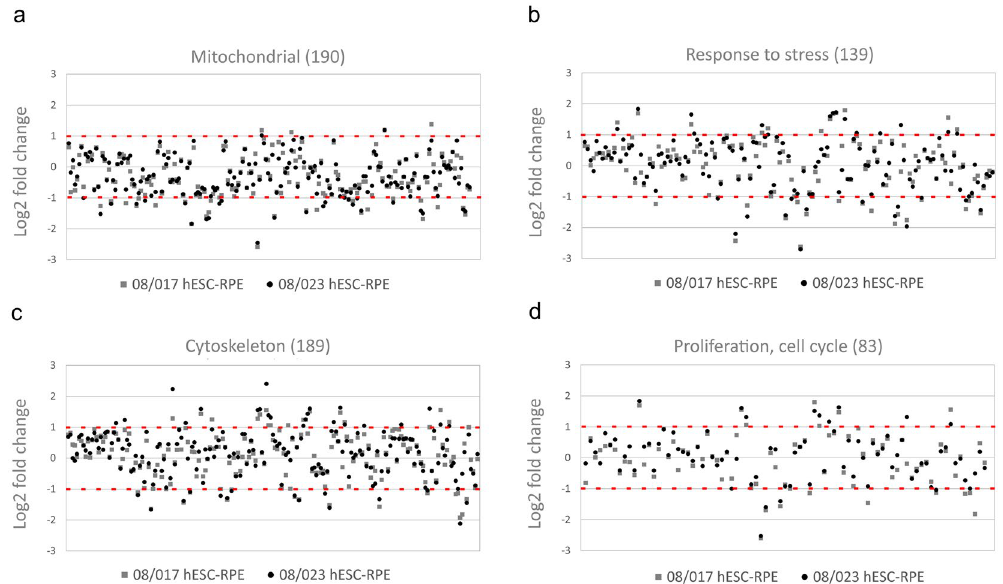
Figure 4. Proteins involved in mitochondrial functions, stress, cytoskeleton, and proliferation. Relative expression of ( a ) mitochondrial, ( b ) cellular stress-related, ( c ) cytoskeletal, and ( d ) proliferation and cell cycle proteins in both hESC-RPE cell lines compared to hRPE. Each dot represents a single protein, presented as mean fold changes on a log 2 scale, where y = 0 denotes equal protein expression. Red dashed lines mark the borders for over and under expression (2-fold difference in expression). For protein names and exact expression values in each class see Supplementary Tables